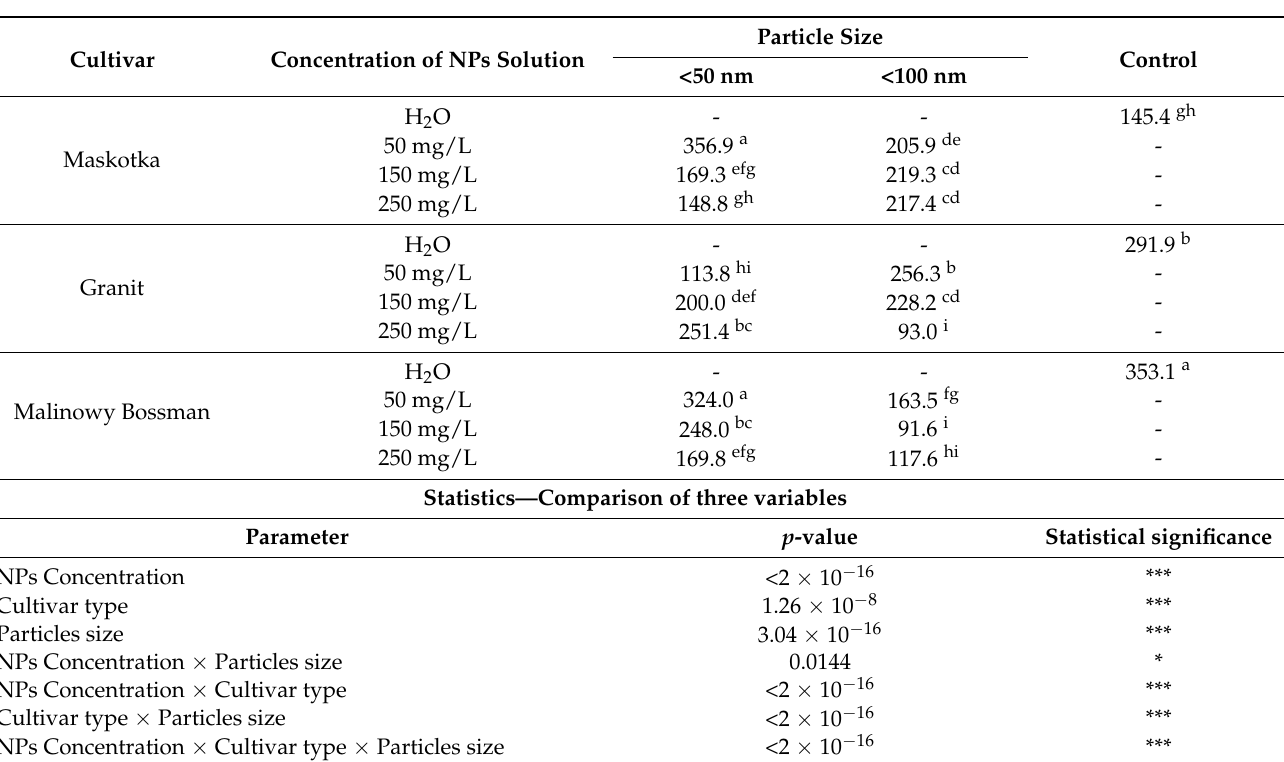
Table A6. The results of vigor index (VI) parameter obtained after treatment and statistic calculations. For this growth parameter, three variables were taken under consideration (NPs suspension, cultivar type, and the size of used NPs). In statistical part of the table, the statistical significance is expressed as “-”, which means that p -value was higher than 0.05 and certain parameters had no significant influence on the results; “*” means that p -value is lower than 0.05, and “***” means that p -value is lower than 0.001. Small letters indicate the significant differences for p -value ≤